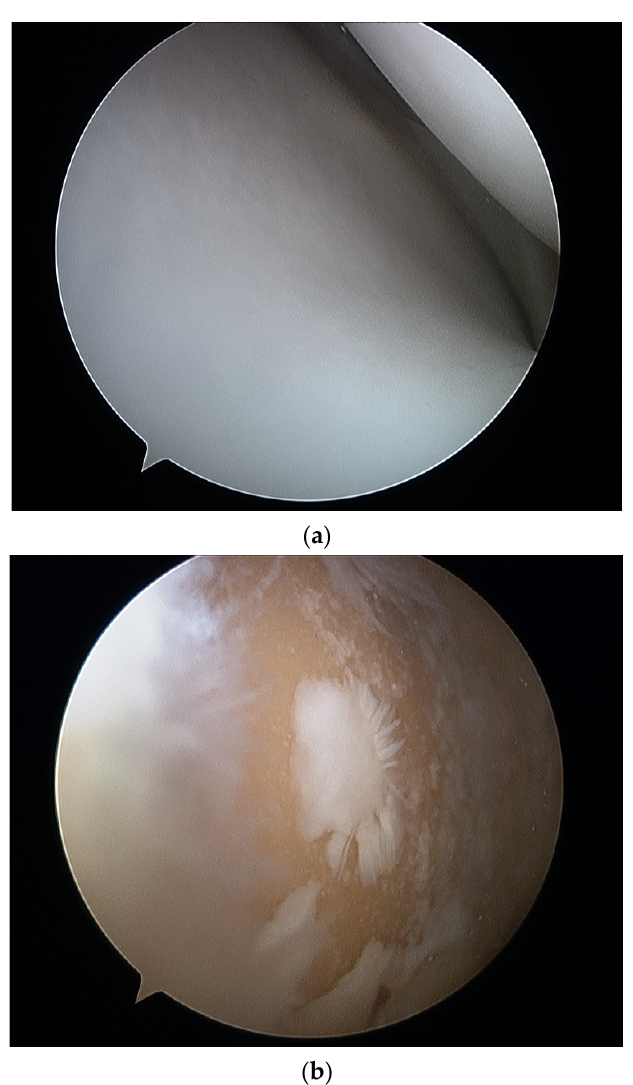
Figure 1. Arthroscopic view of healthy articular cartilage ( a ) and grade IV ( b ) lesion in the tibio- femoral joint.